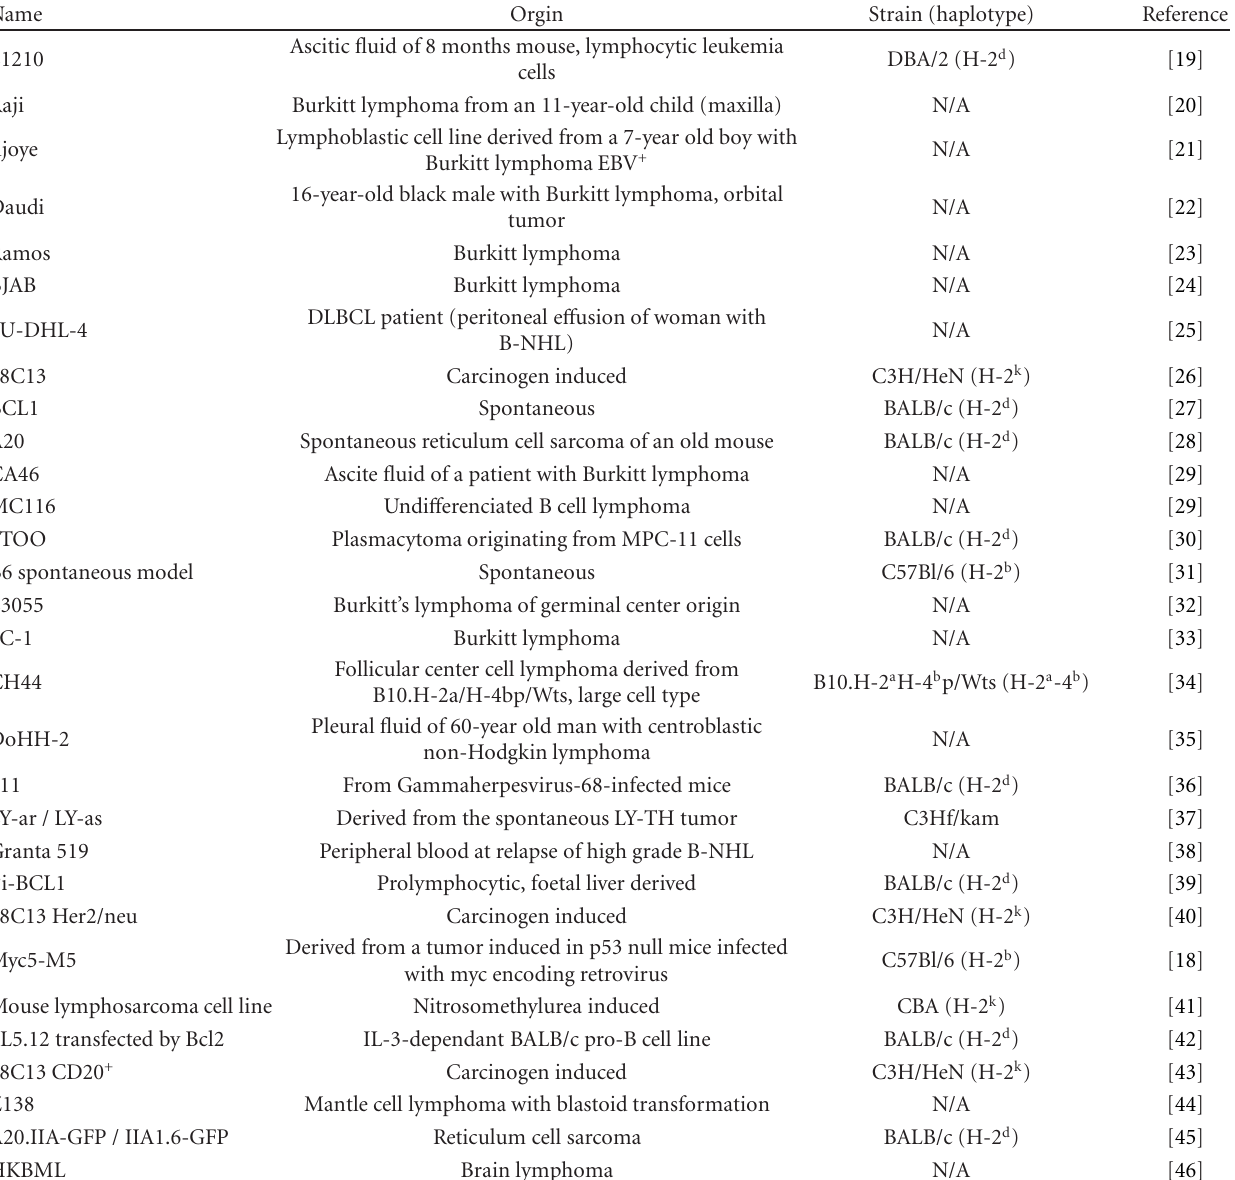
Table 2: Most common B lymphoma cell lines. B-NHL: non-Hodgkin B-cell lymphoma; DLBCL: di ff use large B-cell lymphoma; N/A: not